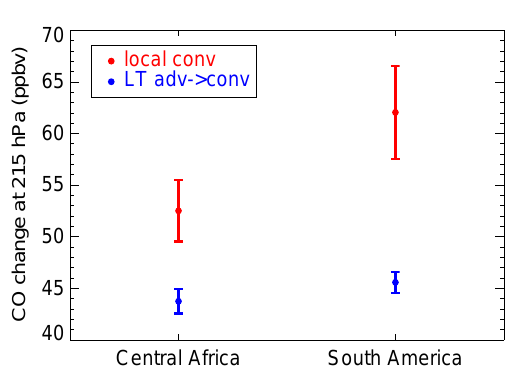
Fig. 9. Annual mean increases in CO concentrations at 215hPa as- sociated with the “local convection” (red) and “LT advection → convection” (blue) CO transport pathways. Error bars encompass ± 2 standard errors of the